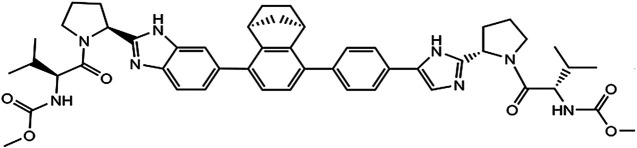
The chemical structure of yimitasvir.